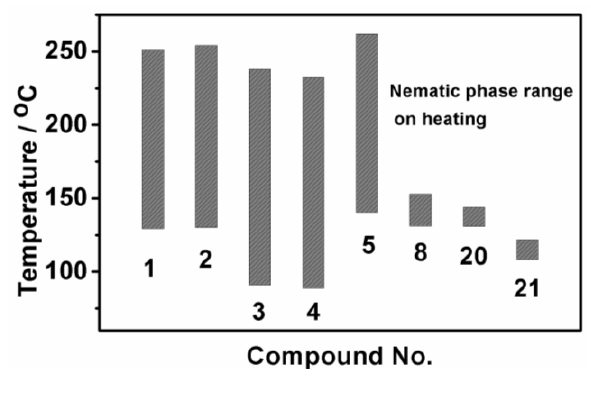
Figure 3. Nematic phase temperature